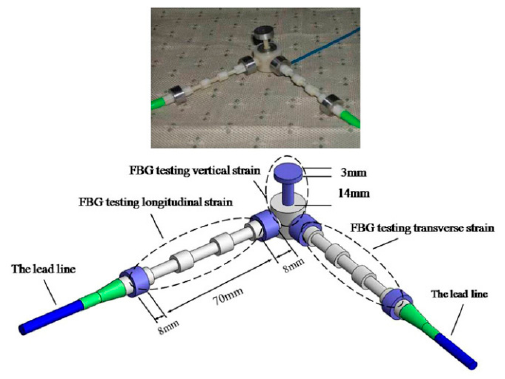
Figure 7. Fabricated 3D strain sensor assembly for 3D structural strain monitoring (figure is reproduced from Zhou et al. [46]).